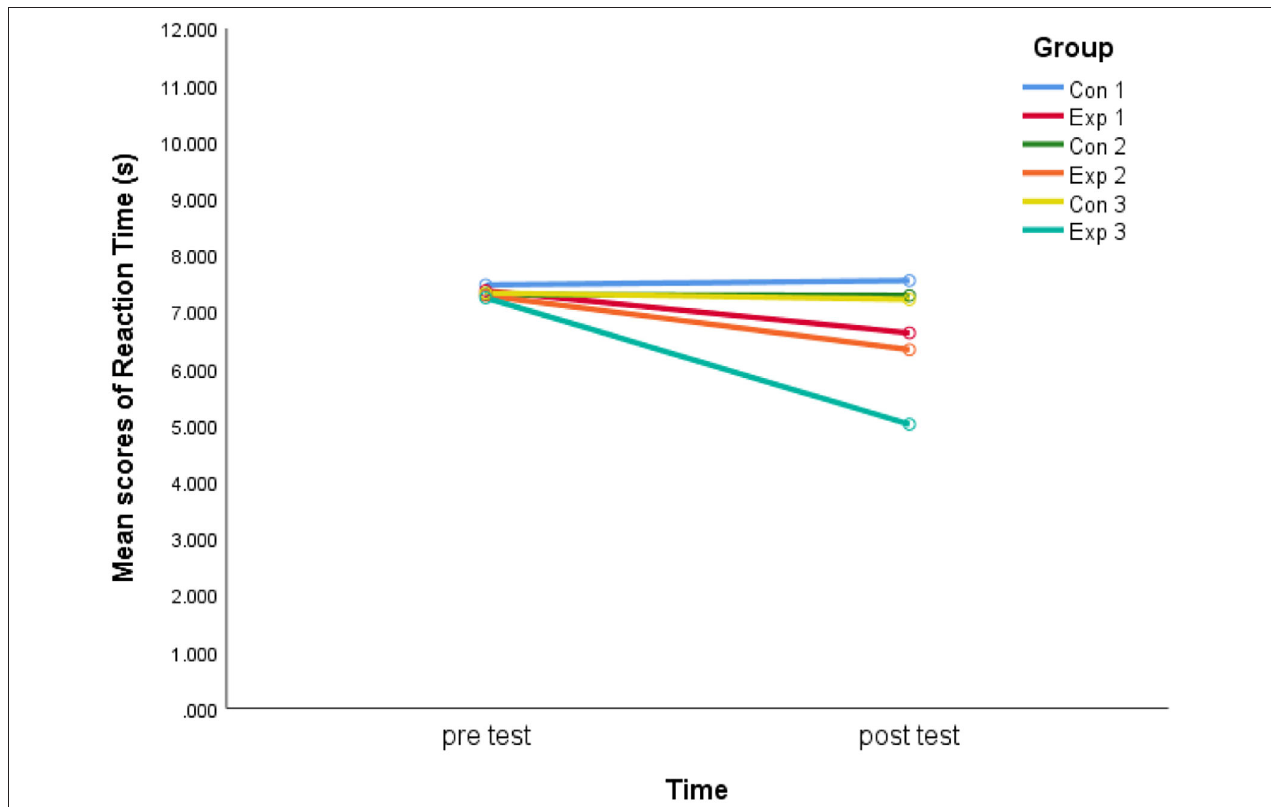
FIGURE 3 | Interaction effect for reaction